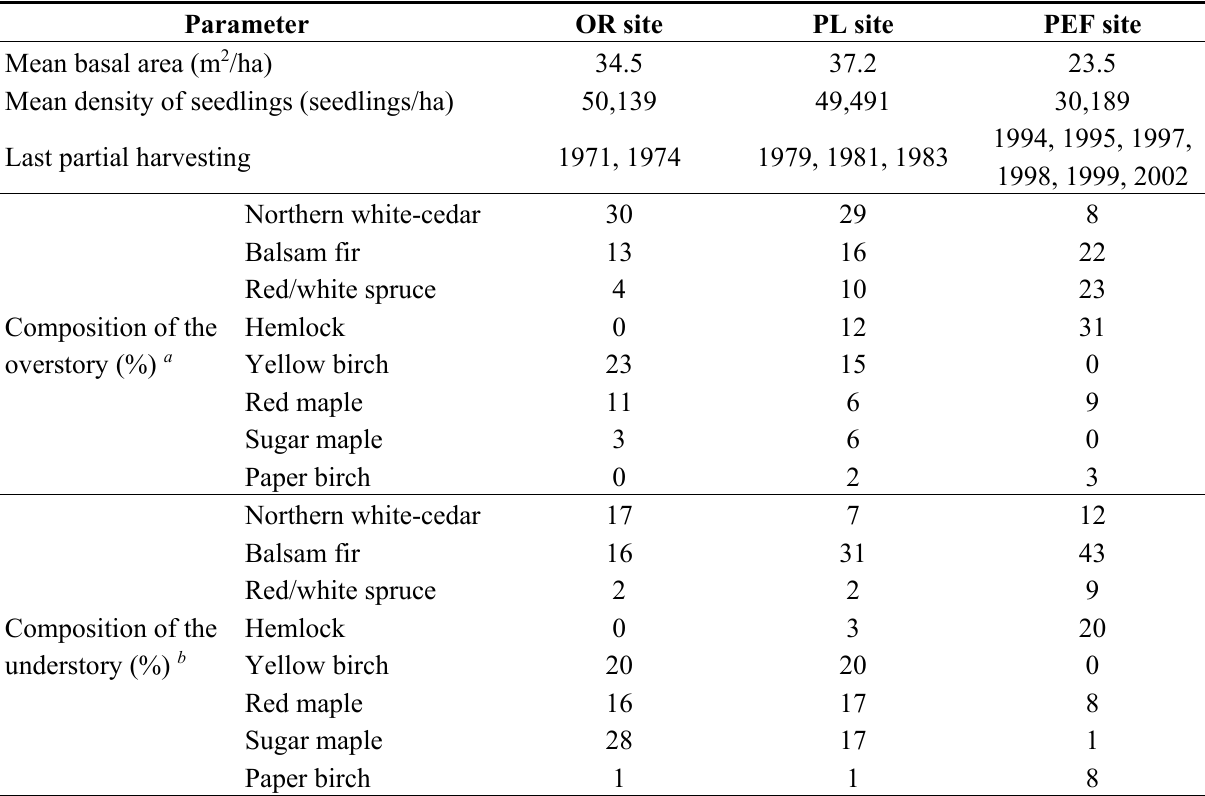
Table 2. Composition of the 3 study sites: Outaouais Region (OR site), Papineau-Labelle wildlife reserve (PL site), and Penobscot Experimental Forest (PEF